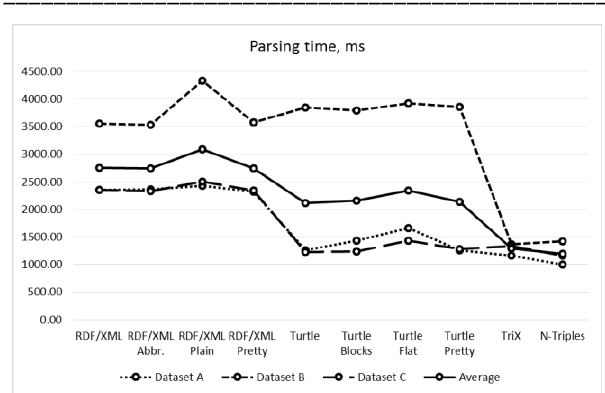
Fig. 8. Parsing time results for all syntaxes.